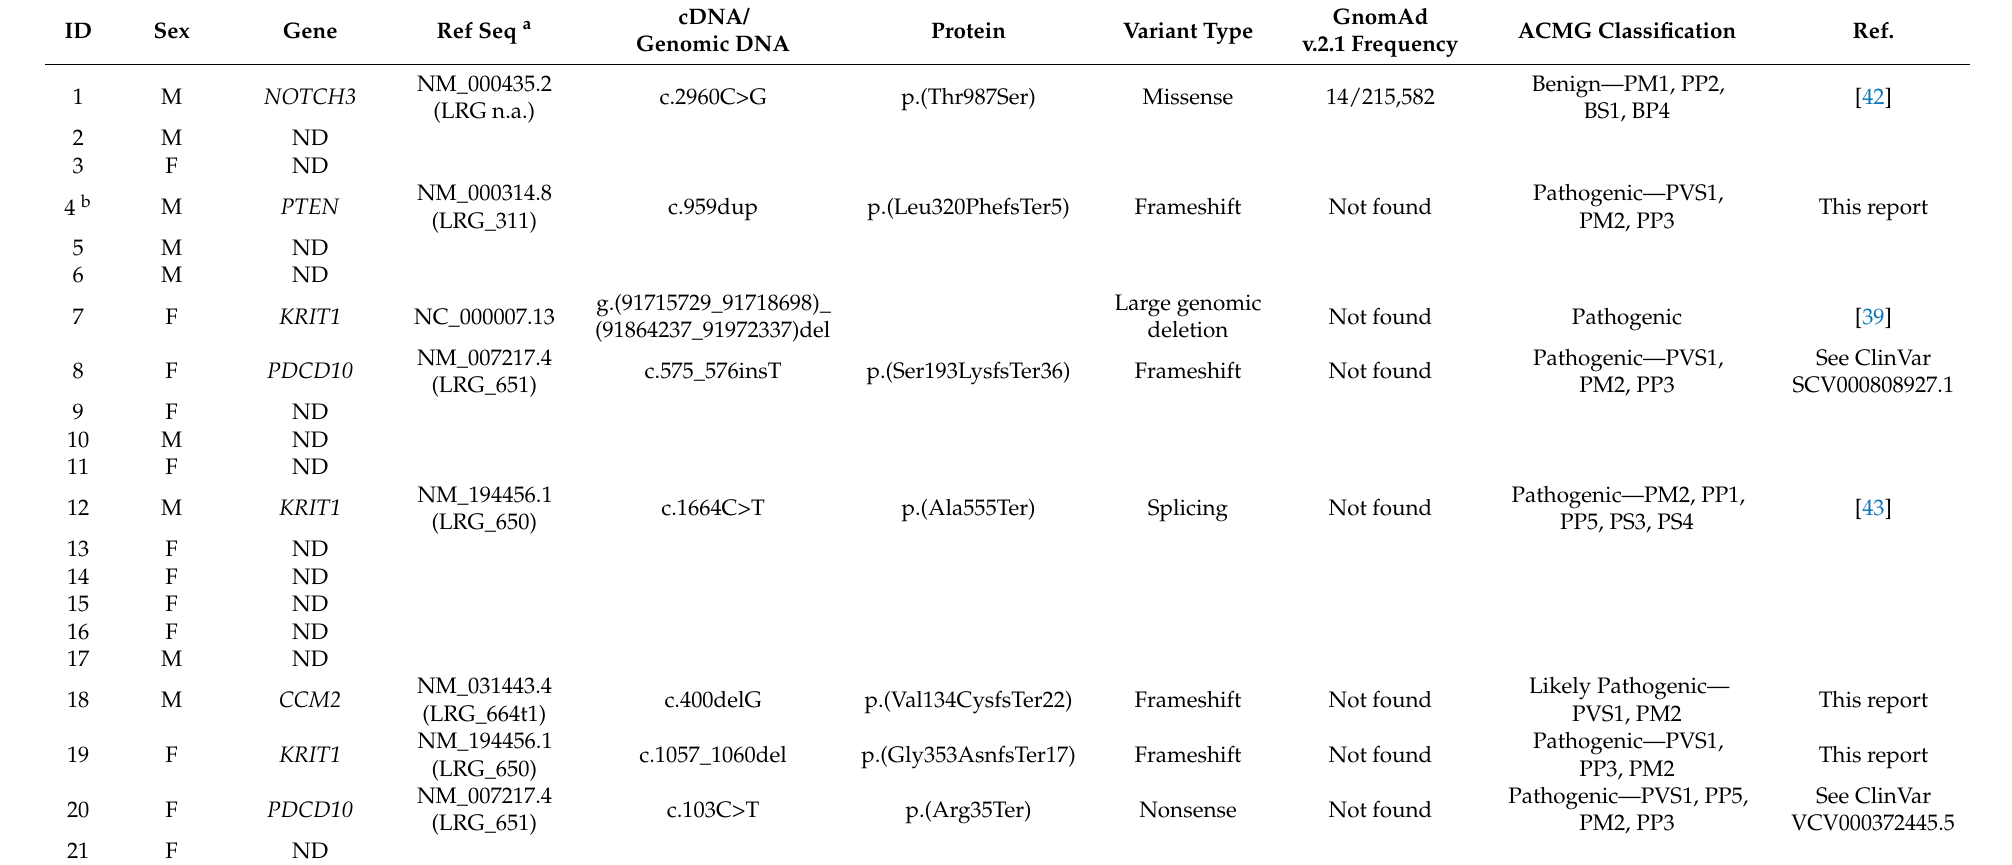
Table 2. NGS screening of 21 patients affected by Cerebral Cavernous Malformation